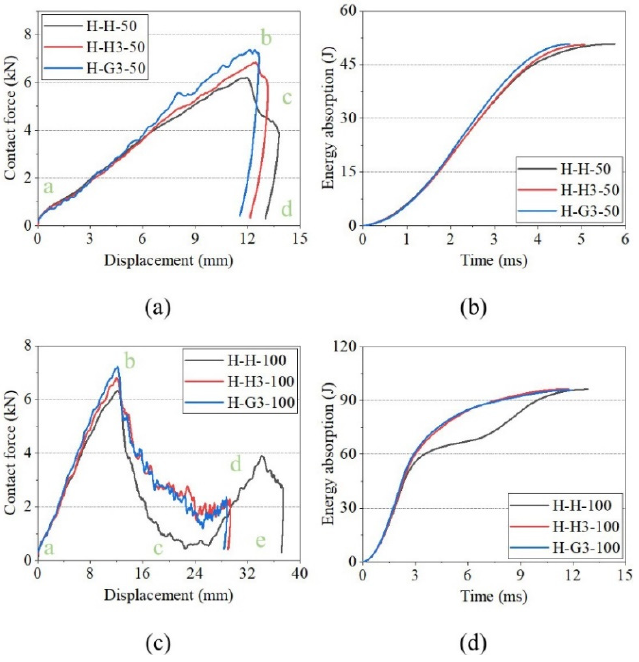
Figure 11. Impact response curves of H, H3, and G3 with hemisphere impactor. (a) Contact force– displacement curves of 50J. (b) Energy-absorption curves of 50J. (c) Contact force–displacement curves of 100J. (d) Energy-absorption curves of 100J.